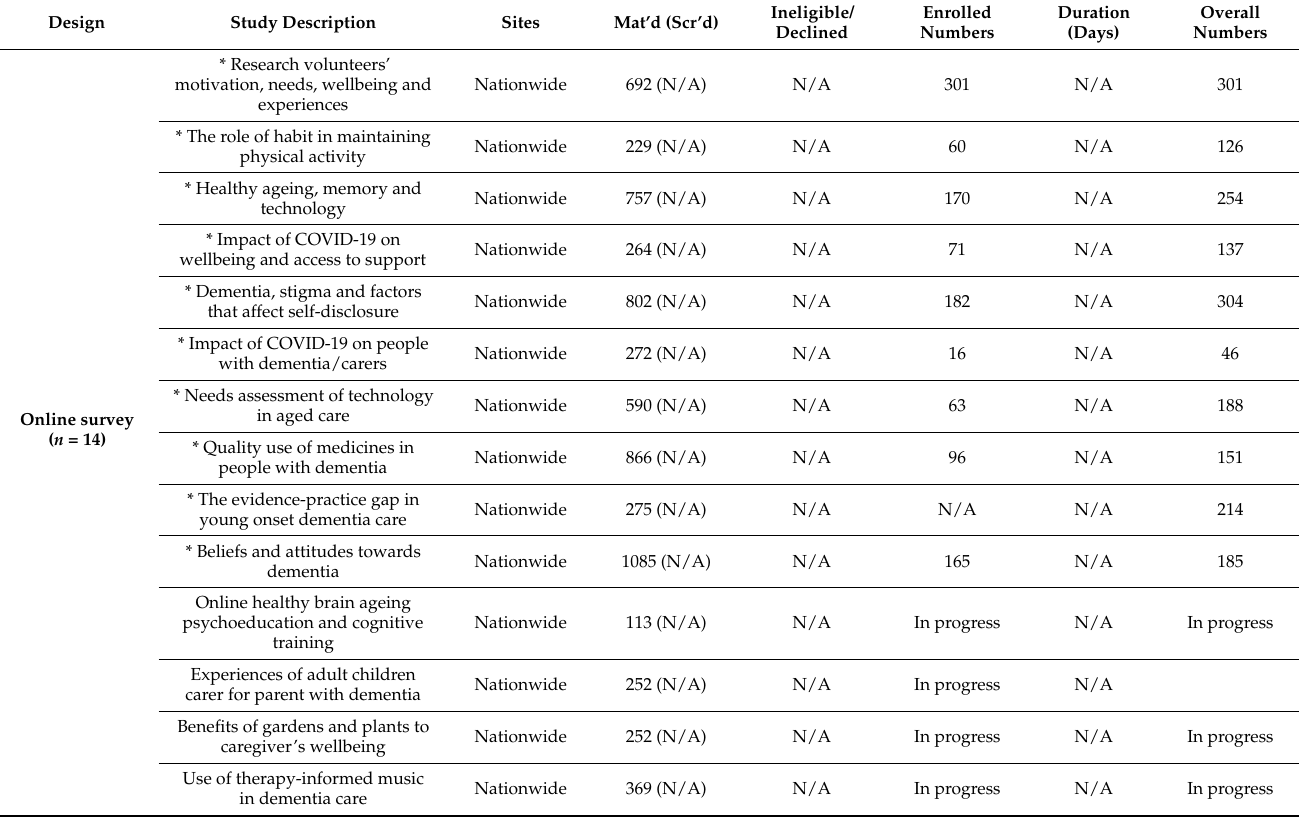
Table 1. Case analysis of studies registered in StepUp for Dementia